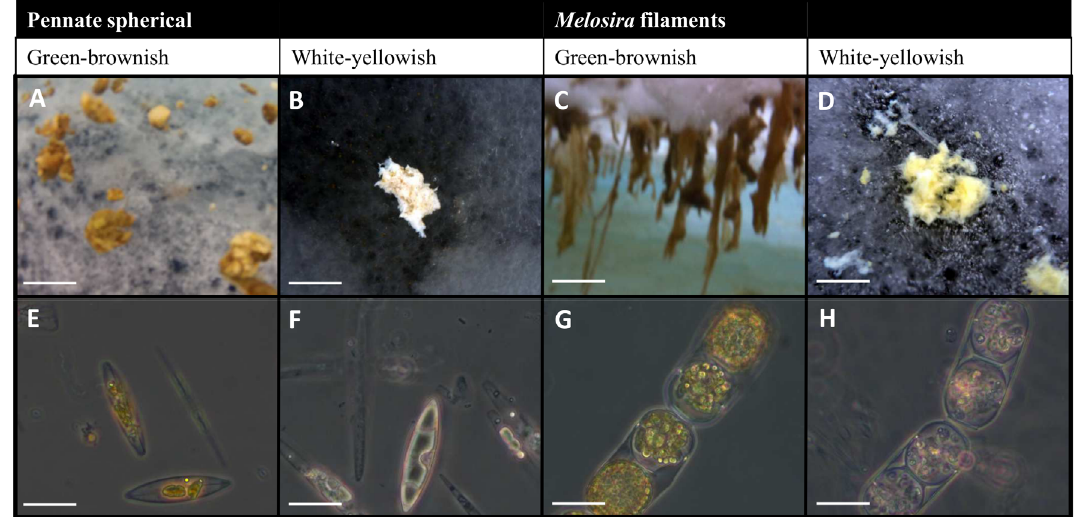
Figure 3. Representative types of aggregates observed. Macroscopic images of the aggregates (A–D) and their microscopic composition (E– H). Fresh spherical floating aggregates below the ice formed by pennate diatoms (A and E). Degraded aggregate trapped in a closed melt pond formed by dead pennate diatoms with empty frustules (B and F). Filaments hanging from newly formed ice over an open melt pond formed by Melosira arctica cells that contain green chloroplasts (C and G). Degraded aggregate formed mainly by dead Melosira arctica cells trapped at the bottom of a partially open melt pond (D and H). Scale bar=5 cm (A), 2 cm (B), 10 cm (C and D), and 20 m m (E–H).